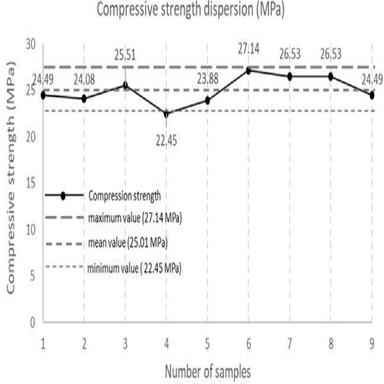
standard deviation of compressive strength.